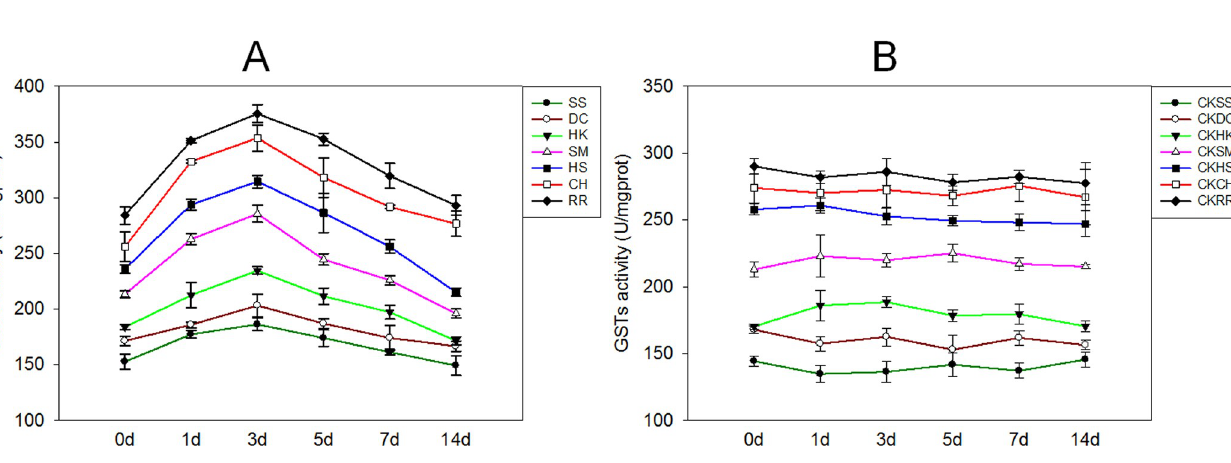
PLOS ONE | https://doi.org/10.1371/journal.pone.0214480 April 4,